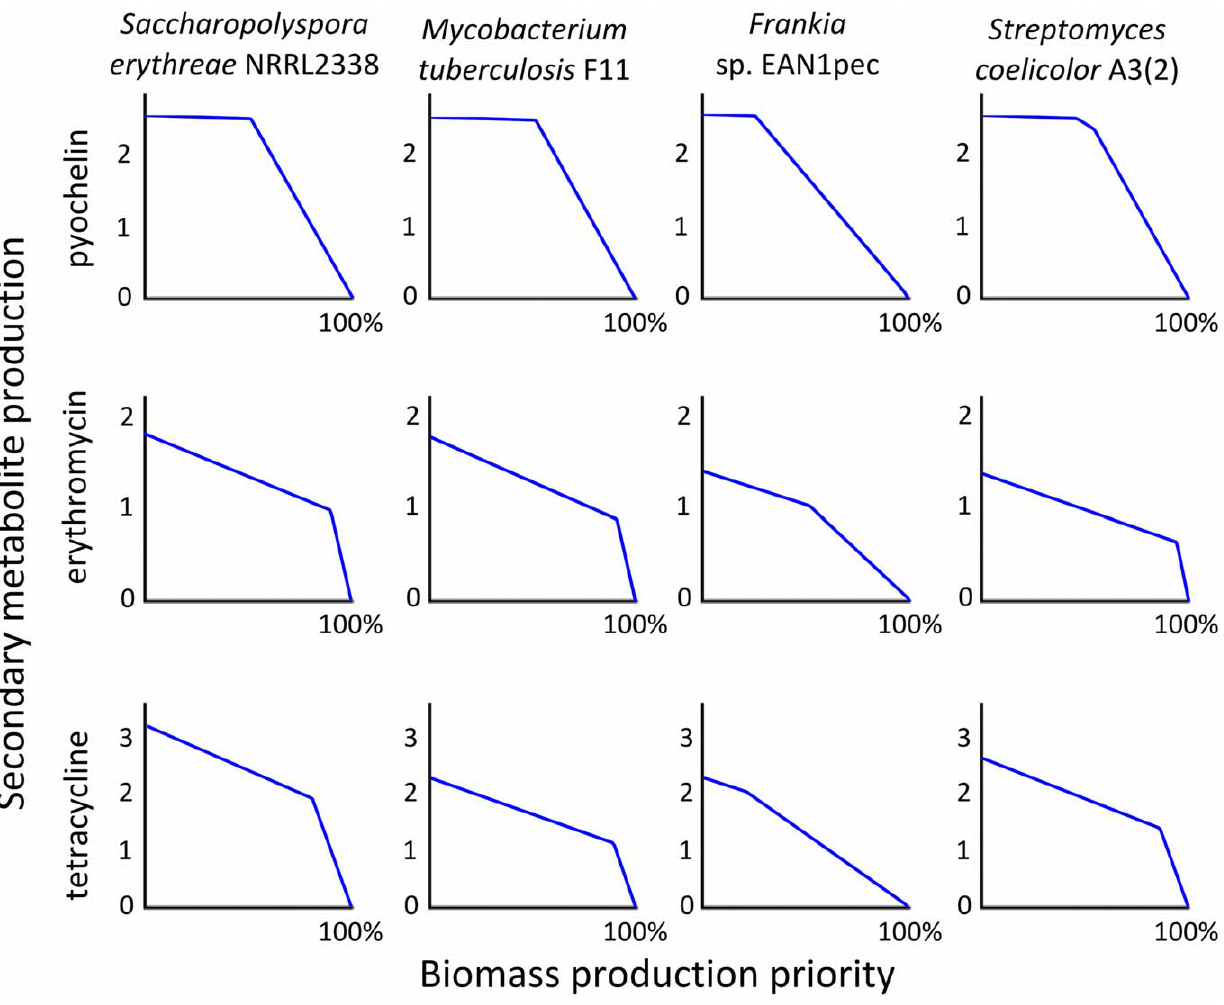
Figure 4. Pareto front calculation between biomass production and secondary metabolite biosynthesis. Pareto fronts are given for four species and three different natural products. To estimate secondary metabolite production, the flux rate through the final step in the biosynthetic pathway of the corresponding compound was used as a proxy.